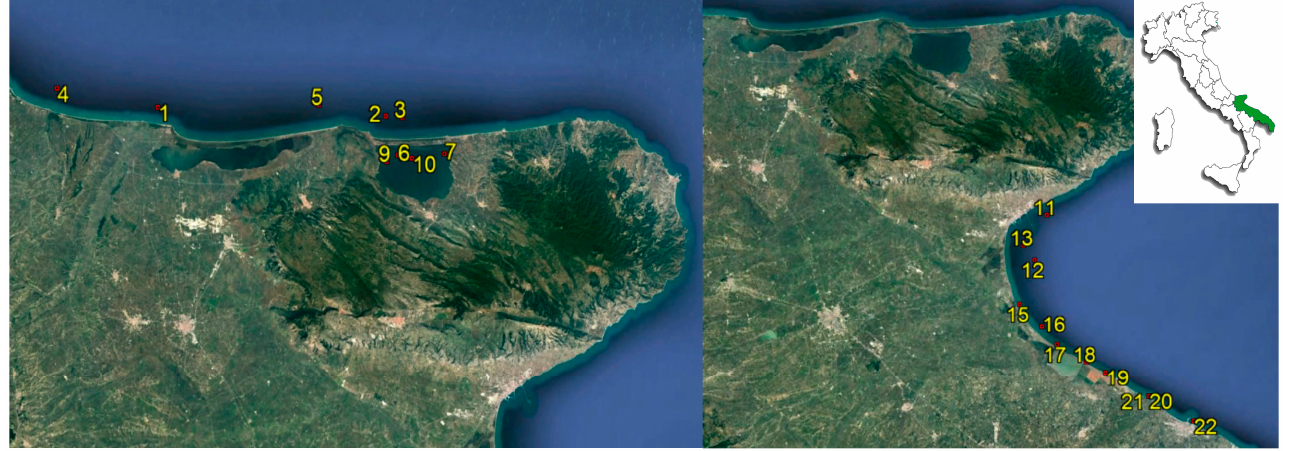
Figure 1. Sampling station locations.